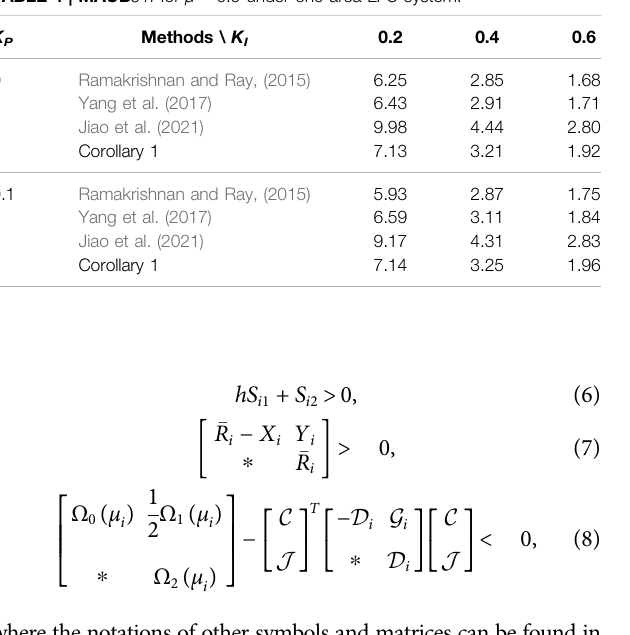
TABLE 4 | MAUB s h for μ (cid:2) 0.9 under one-area LFC system.